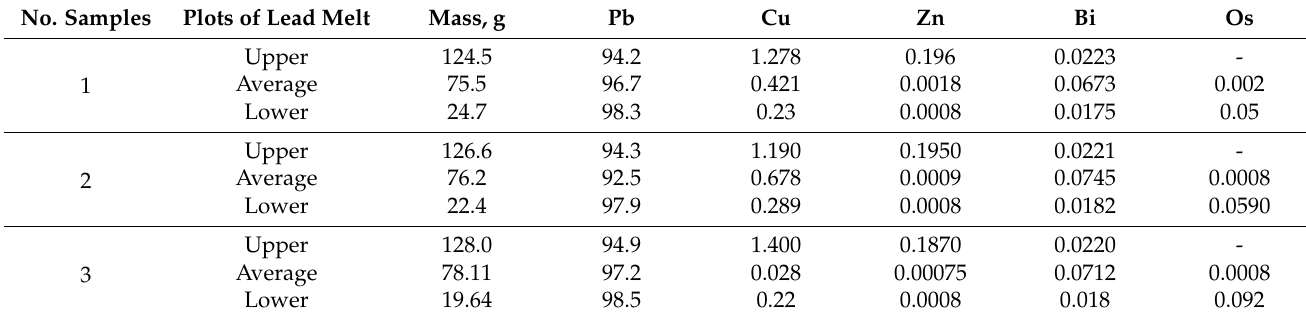
Table 5. Chemical composition of various sections of the lead melt,